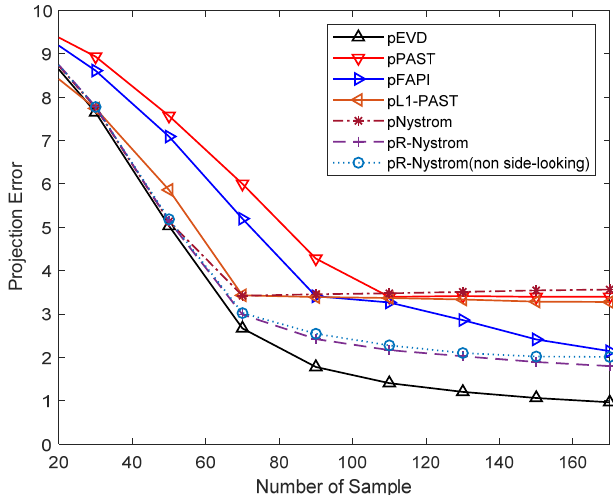
Figure 3. Projection error versus training samples.